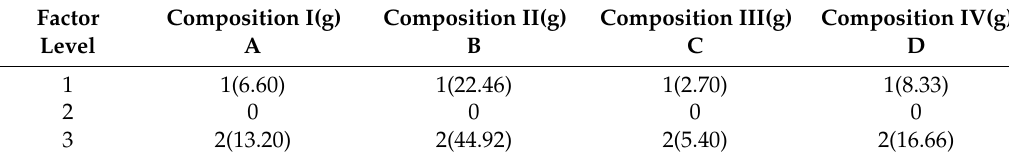
Table 2. Factors and levels selected.